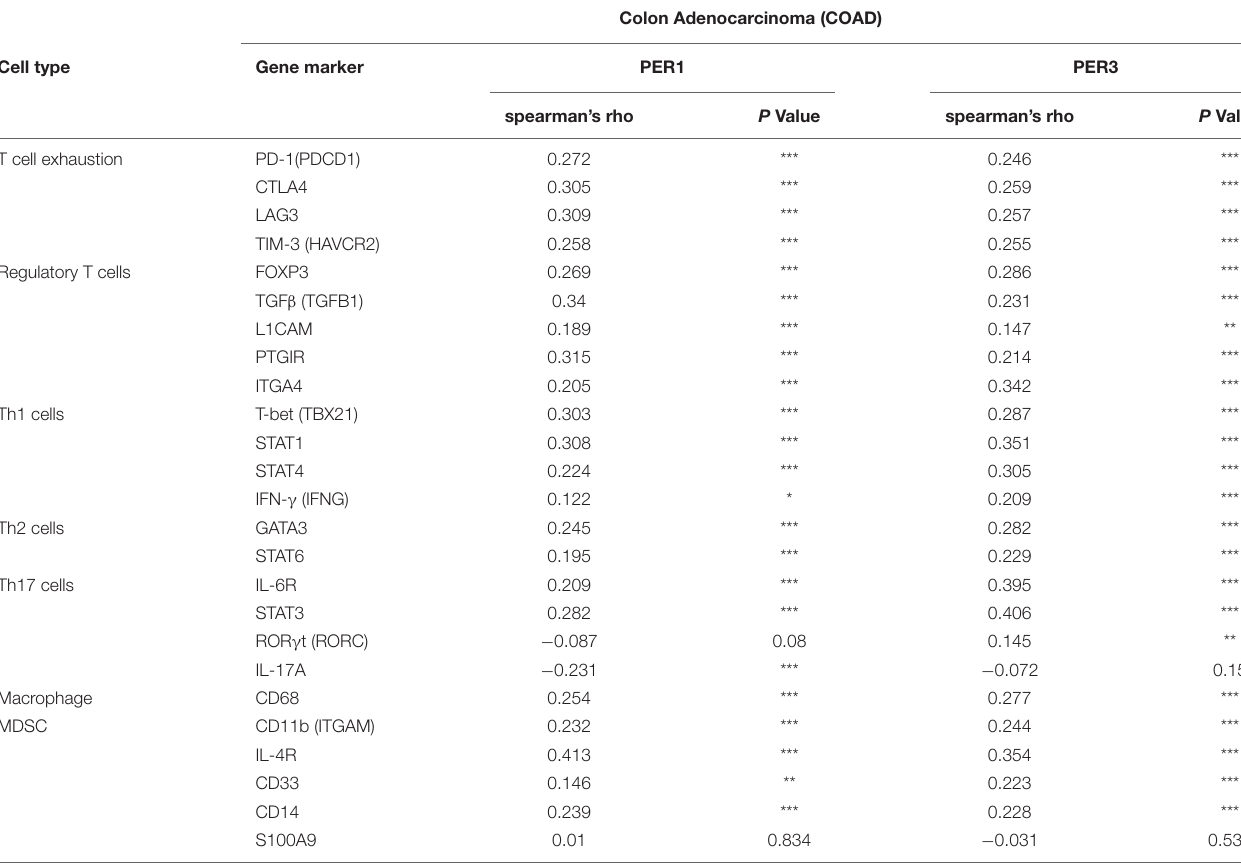
TABLE 3 | Correlations between PER1, PER3, and gene representatives of various functional cell subsets in COAD determined by TIMER2.0. Colon Adenocarcinoma